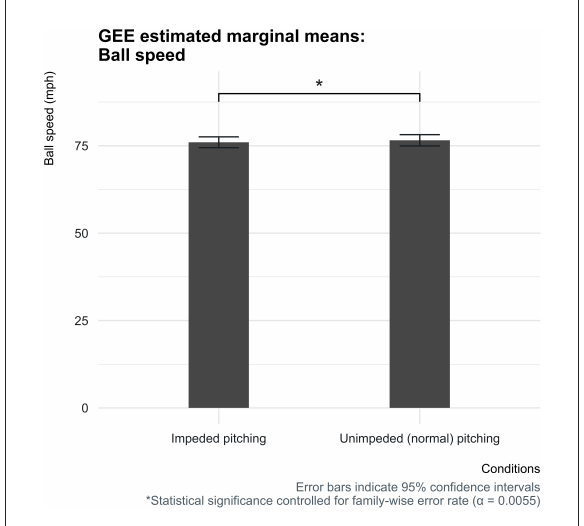
FIGURE4 Estimated marginal means for the ball speed for both conditions with corresponding 95% confidence interval error bars.